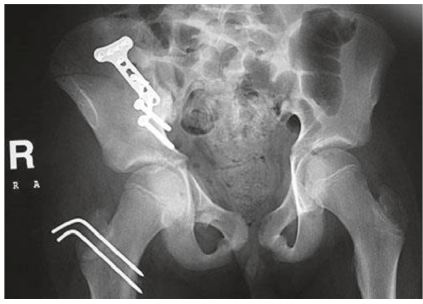
Figure 3: Postoperative AP pelvic X-ray showing adequate open reduction internal